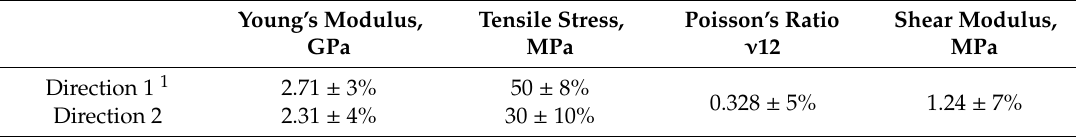
Table 1. Values of physical constants for the printed